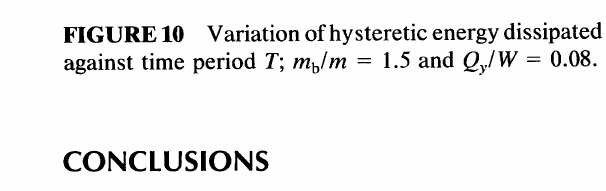
FIGURE 10 Variation of hysteretic energy dissipated against time period T; mb1m = 1.5 and QylW = 0.08.